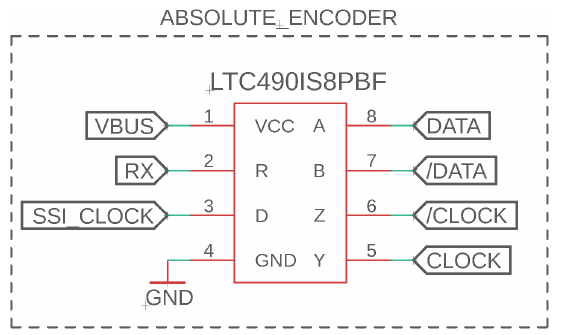
Figure 6. Circuit design for absolute encoders that output differential clock and data signals, which can be interpreted using an SSI module.